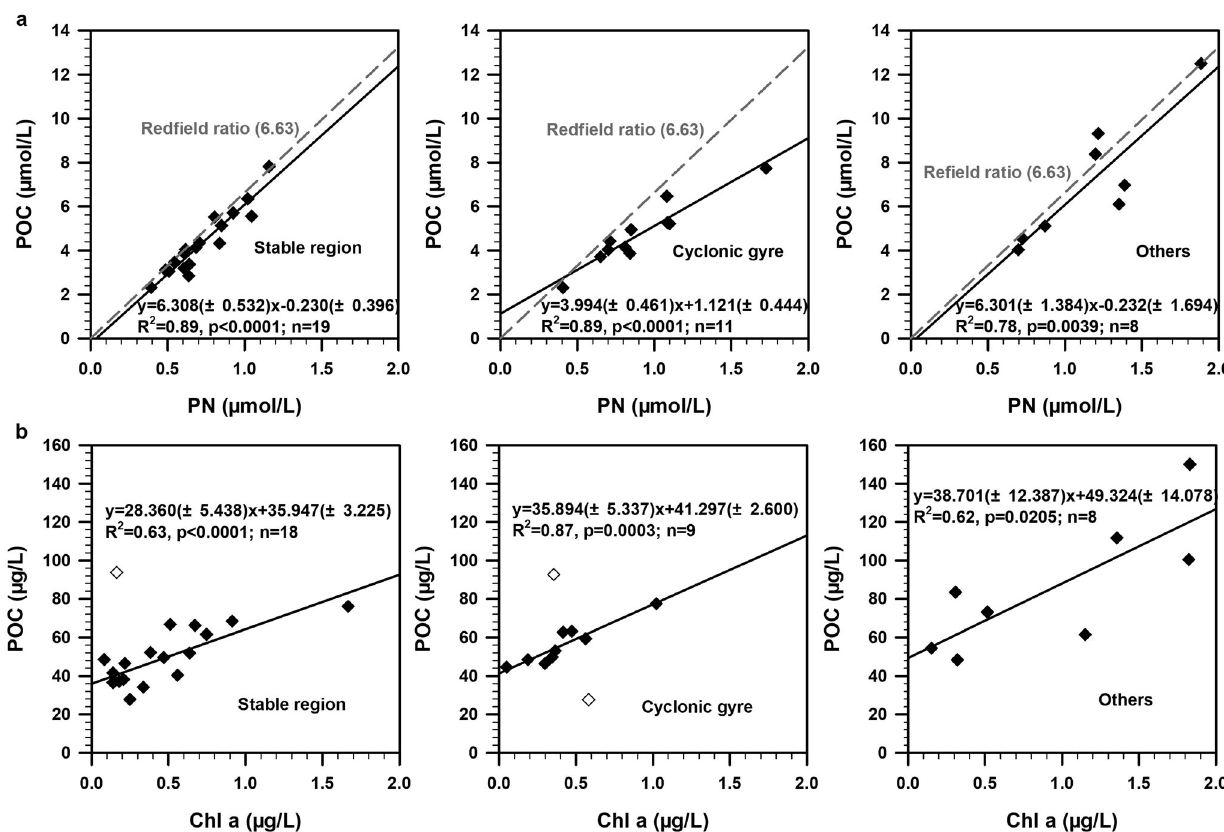
Fig. 2 Marine phytoplankton source of suspended particulate organic matter. a Relationships of POC vs. PN concentrations in three groups of DCM stations. Note that almost all of the data points fall below the line of the Red fi eld ratio 66 . b The covariation of POC and Chl a concentrations also indicates the predominant source of marine plankton in the POM at the DCM layer of SYS. Open diamonds in b were not included in regressions. The numbers within parentheses of the fi tted equation represent standard